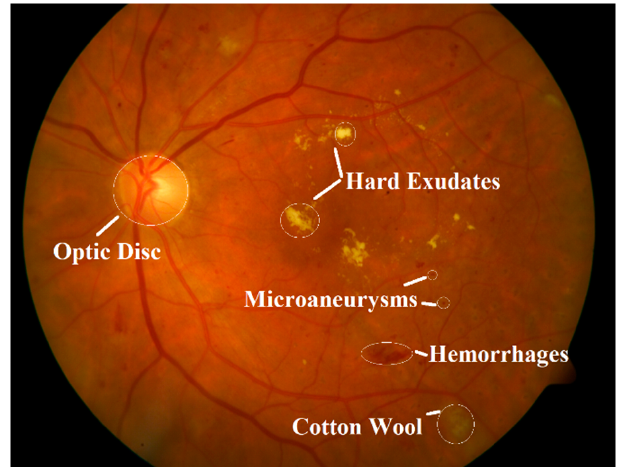
Figure 4. Diabetic retinopathy retinal image showing lesions.